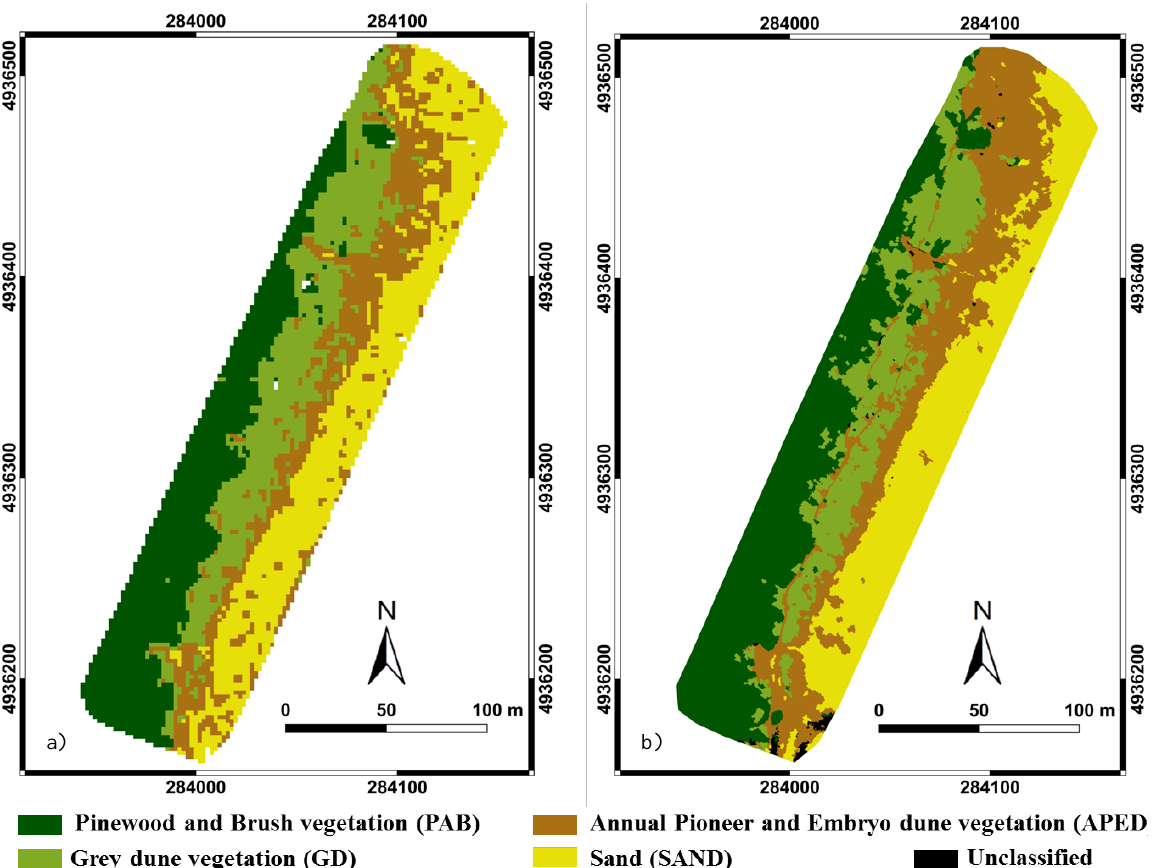
Figure 3. Object-based classification of Casal Borsetti dune vegetation: Worldview-2 data (a) and UAV Orthophoto (b).